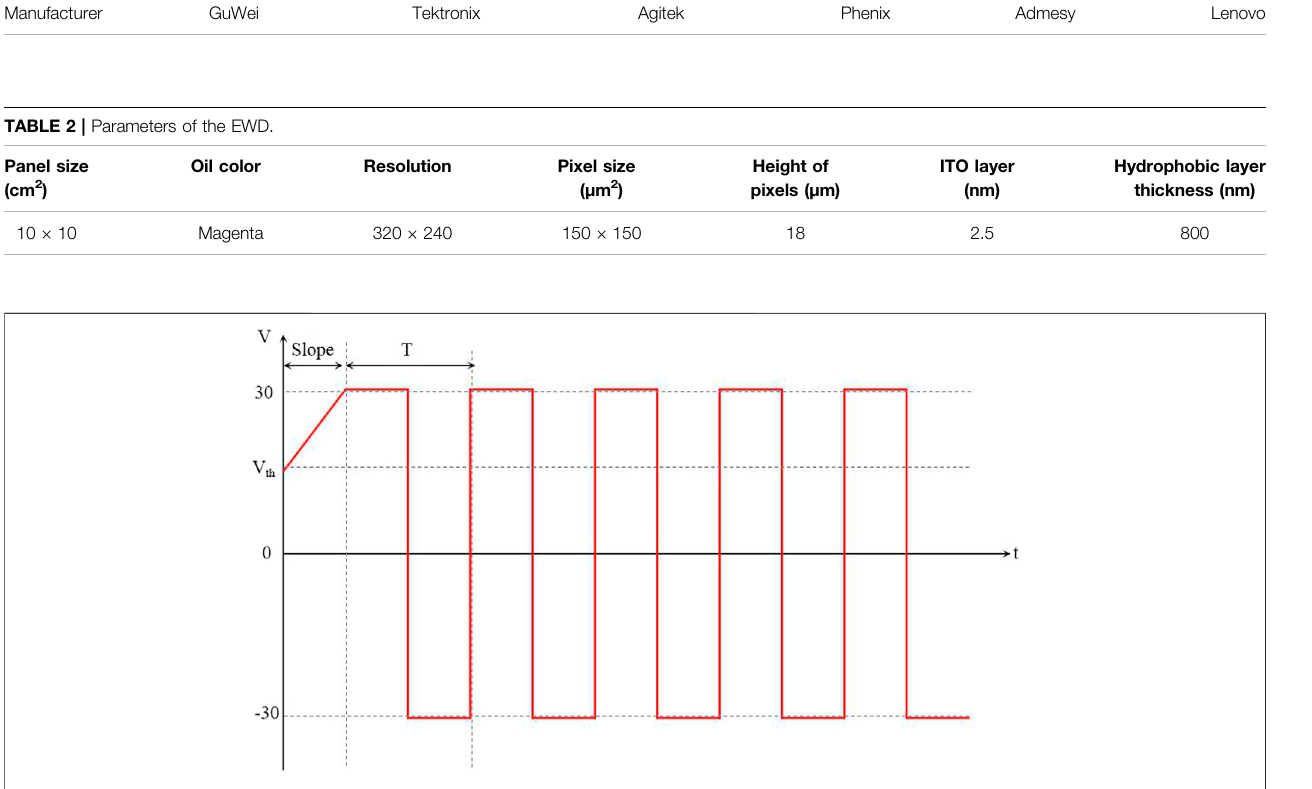
FIGURE 6 | Schematic diagram of a combined pulse waveform with rising gradient design. The proposed driving waveform contained two stages. The fi rst stage was a rising gradient with slope from V th to 30 V. The second stage was a pulse waveform with a suitable period.